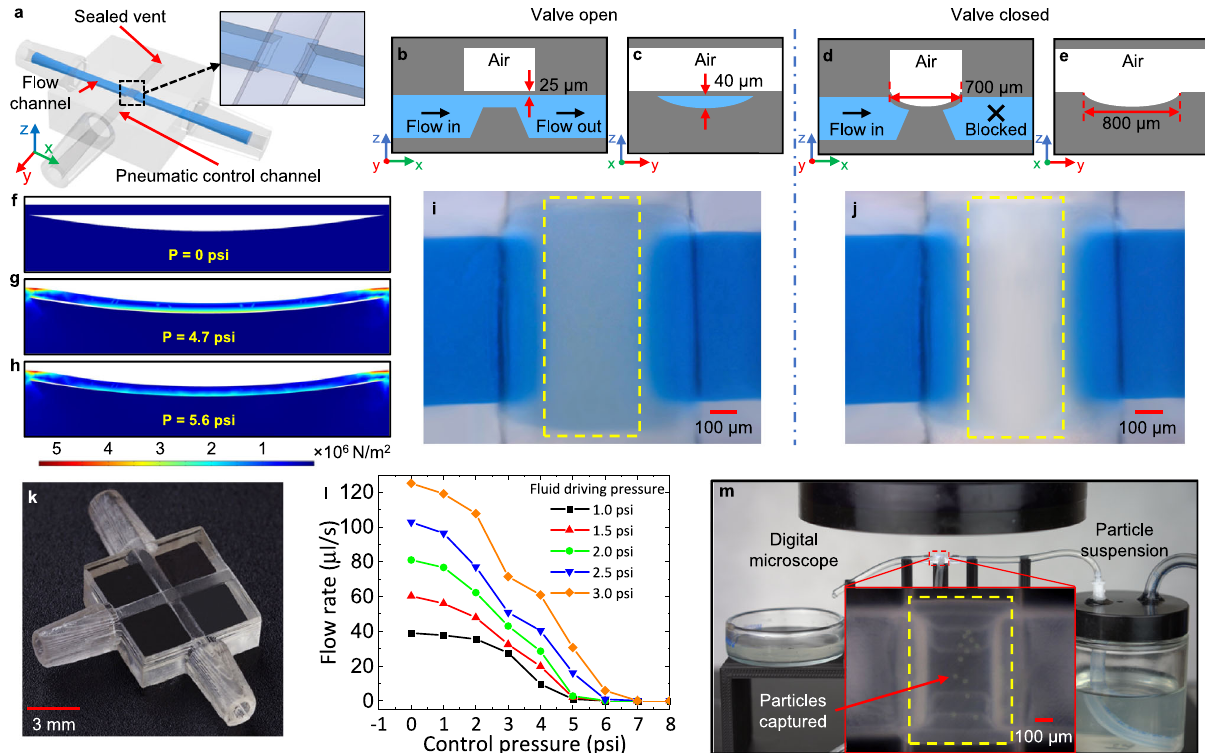
Fig. 4 3D-printed micro fl uidic valve and specimen platform for automation. a CAD model showing the con fi guration of the 3D-printed micro fl uidic valve. The vent at the end of the control channel will be sealed via construction glass glue after clearing uncured resin. The inset gives the detailed structure of the membrane and the ramp. Schematic diagram showing the front b and side c sectional view of the valve fi lled with blue-dyed DI water in the open state. Schematic diagram showing the front d and side e sectional view of the valve in the closed state. The liquid cannot pass through. The membrane is fully conformal to the curved ramp surface under pressure. FEA simulation of the valve membrane de fl ection at different pressures. f 0 psi. g 4.7 psi. h 5.6 psi. The color heat map shows the von Mises stress on the membrane at these pressures. i Microscope image showing the top view of the valve in the open state. j Microscope image showing the top view of the valve in the closed state. The liquid between the ramp and the membrane is displaced. k Fabrication result of the micro fl uidic valve (isometric view). l Closing pressure test of the fabricated valve under varying fl uid driving pressures. m Specimen platform for particle samples observation and measurement. The de fl ected membrane captures the green